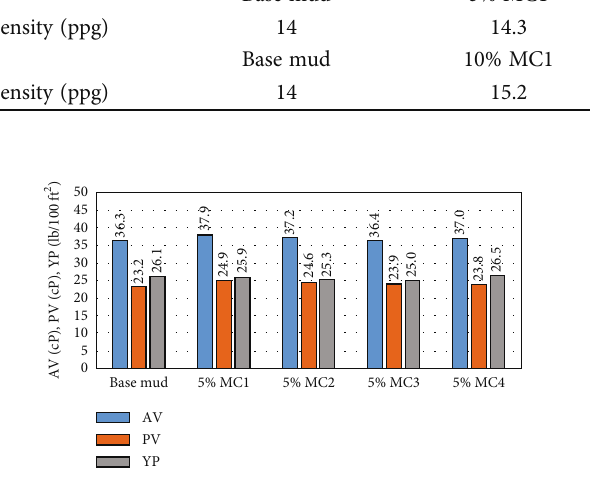
Figure 8: Rheological properties as function of adding 10% of di ff erent cuttings to the base mud.